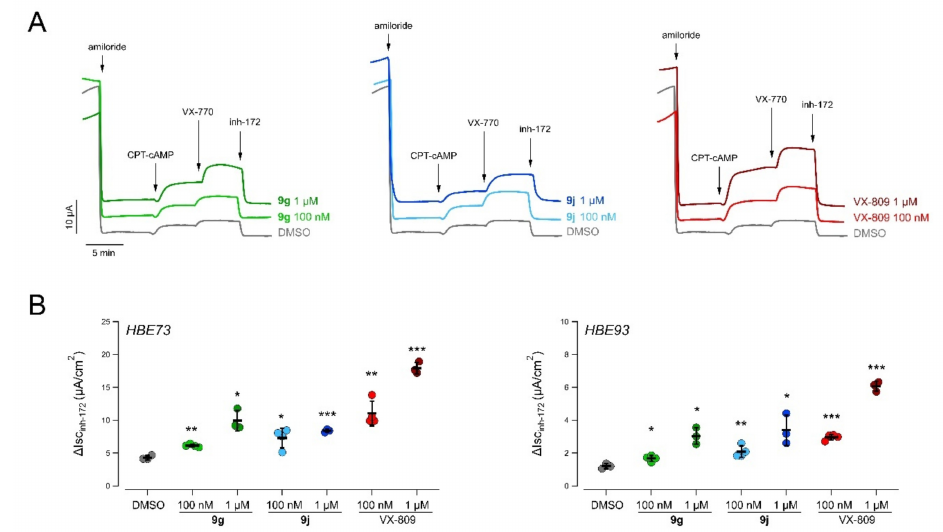
Figure 9. Evaluation of the effect of hybrid derivatives 9g and 9j on F508del-CFTR activity measured on human primary bronchial epithelia derived from two CF patients: ( A ). Representative traces from Ussing chamber recordings of human primary bronchial epithelia derived from a homozygous F508del patient (donor code: HBE73) following 24 h treatment with DMSO alone or indicated test compounds. ( B ). Dot plots summarizing CFTR-mediated currents from Ussing chamber recordings of human primary bronchial epithelia derived from two homozygous F508del patients (donor codes: HBE73 and HBE93) treated as described in ( A ). Analysis of variance was calculated for the groups. Asterisks indicate statistical significance versus negative control: * p < 0.05; ** p < 0.01; *** p <